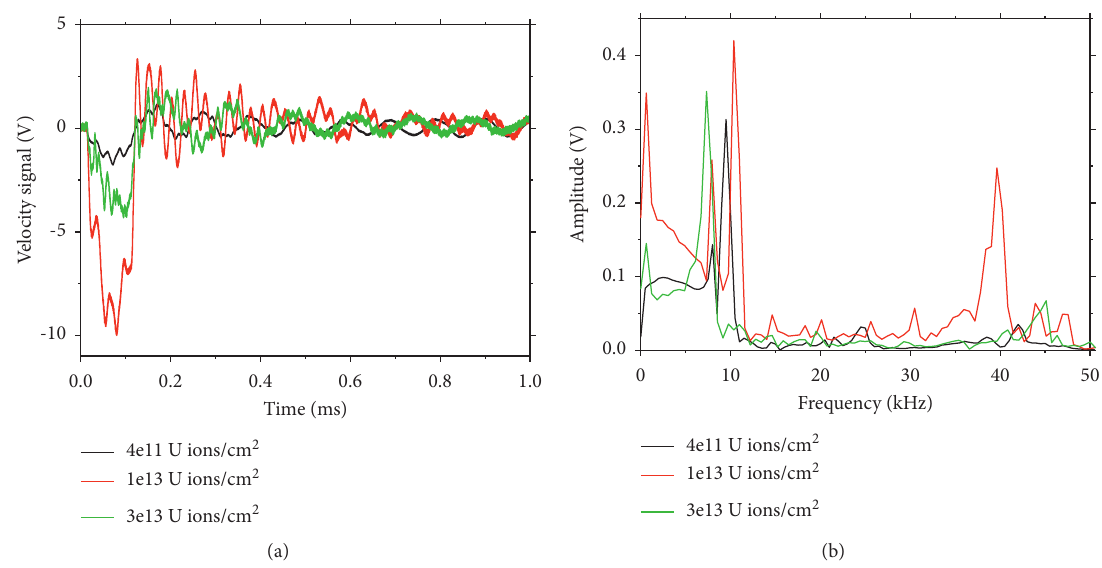
Figure 8: (a) LDV velocity signal as a function of time and (b) corresponding FFTspectra measured at the rear side ( x � y ≈ 0, z � 0.5) of a 0.5mm-thick h-BN disc under irradiation with 1.14GeV U-ions at different fluences.